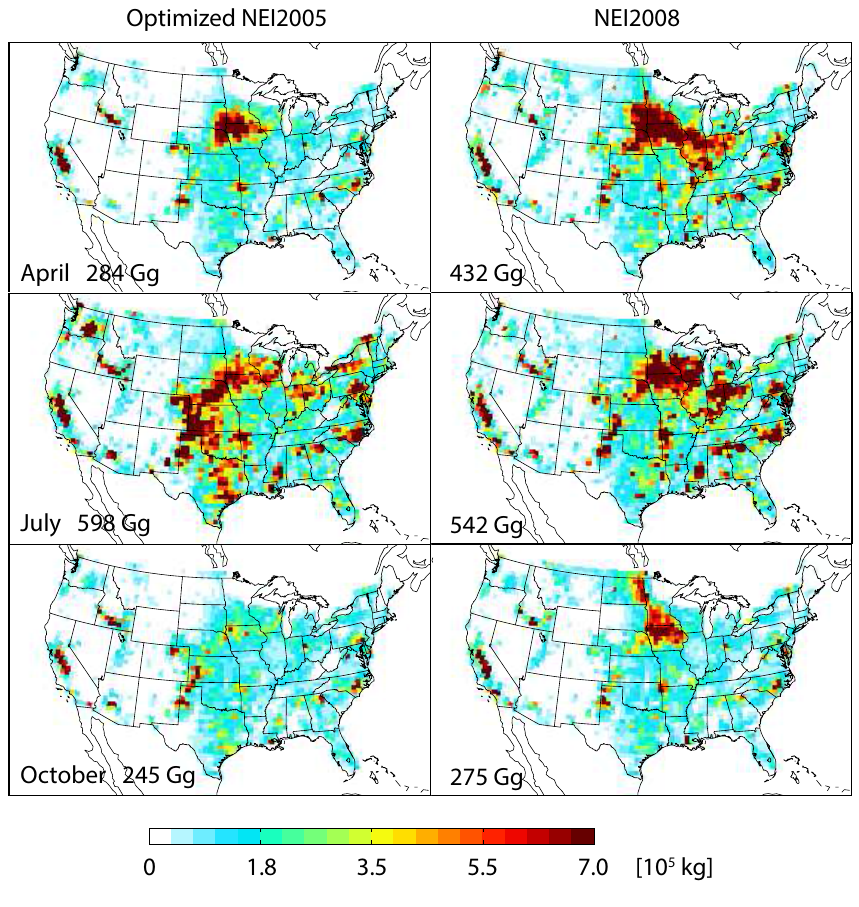
Figure 11. Sum of NH 3 emissions from anthropogenic, natural, biomass burning, and biofuel sources. Inset numbers are contiguous US total NH 3 emissions in each month.